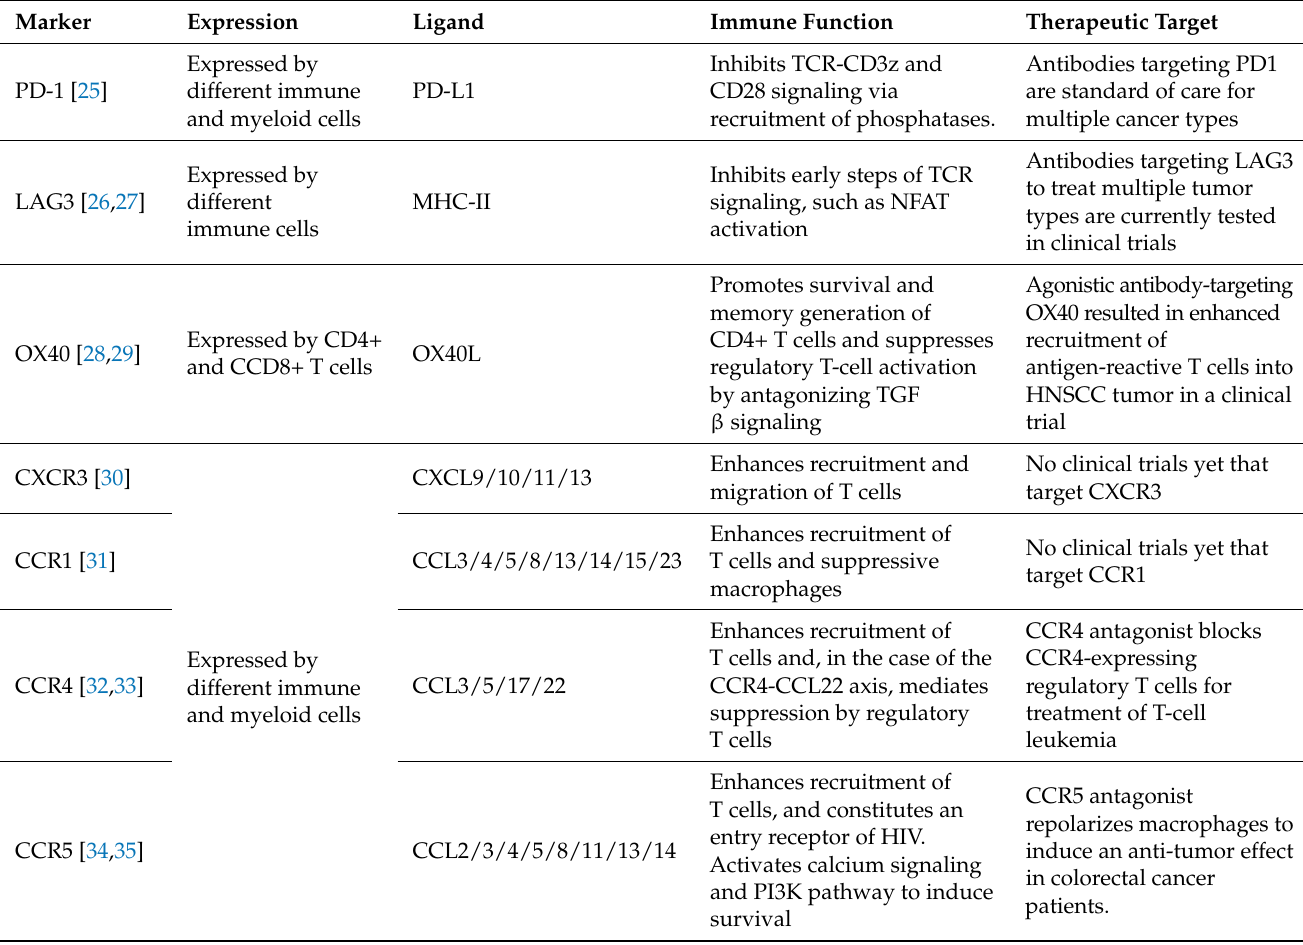
Table 2. List of selected T-cell markers that show changes in blood of NPC patients upon radiotherapy according to plasma EBV DNA